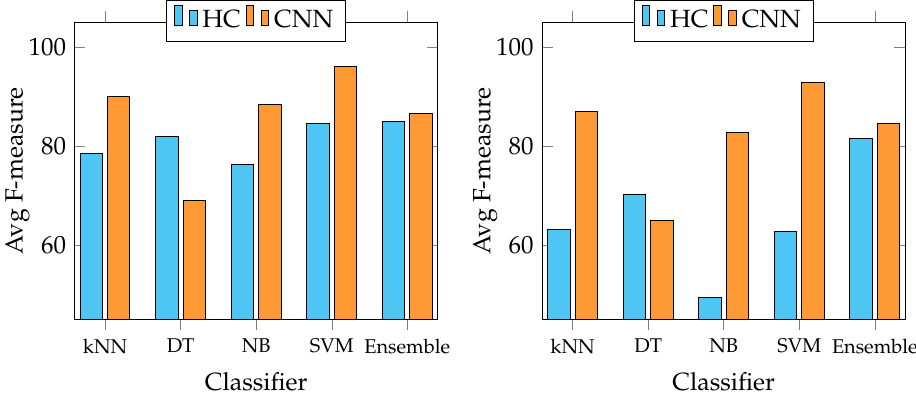
Figure 6. Average MFM trends with the different classifiers adopted. On the left, average MFM obtained on Canada data set; on the right, on Cagliari data